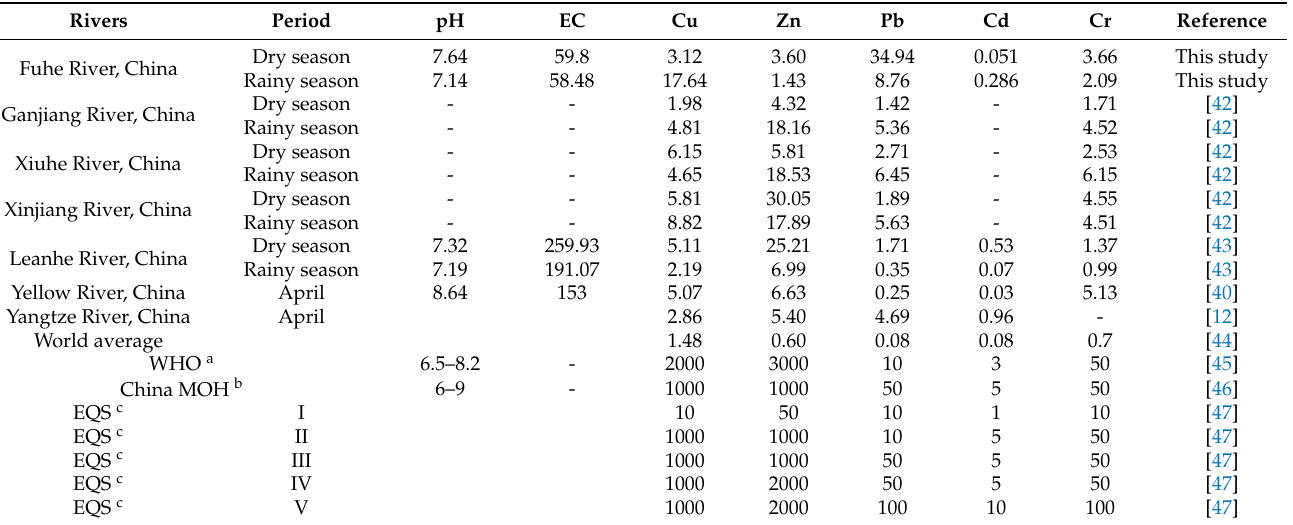
Figure 2. The statistical summary of ( a ) pH, ( b ) EC values, and ( c ) heavy metal concentrations of the